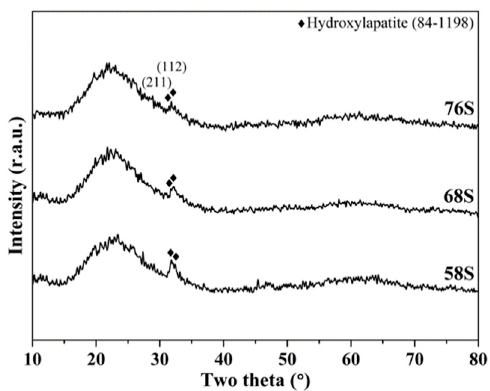
Figure 6 XRD patterns of 58S, 68S, and 76S BG powders soaked in simulated body fluid (SBF) for 12 h.